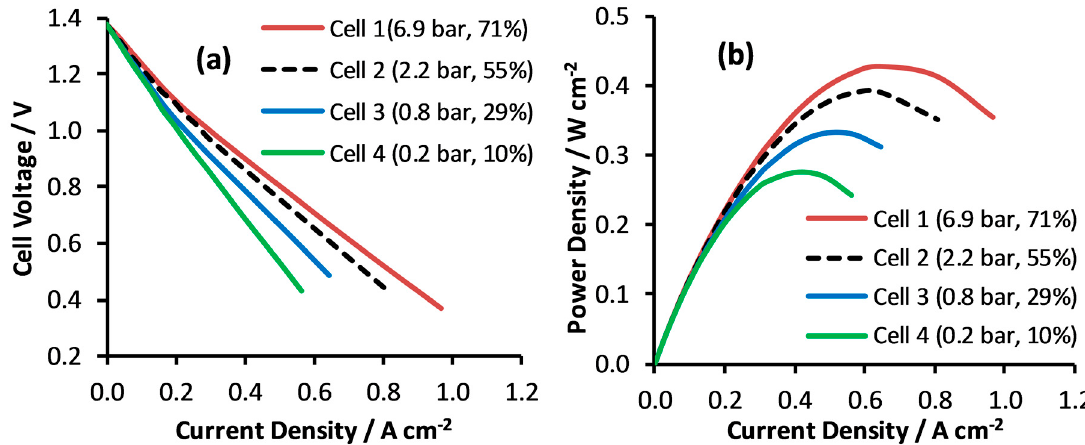
Figure 3. Plots of ( a ) cell operating voltage and ( b ) cell power density against current density for Cells 1–4 (labeled) with a range of active area compression pressures and % compression values. C 2018 , 4 , x FOR PEER REVIEW